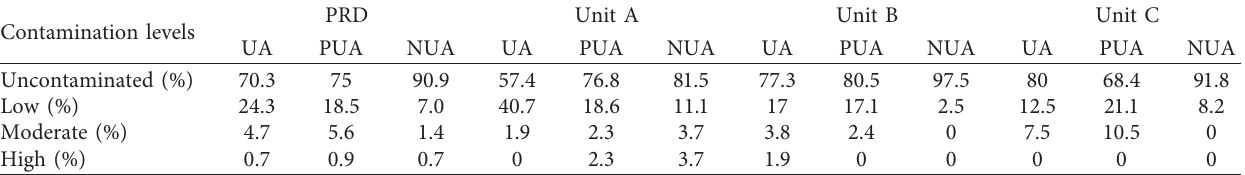
Table 2: Groundwater salinity contamination in areas with different urbanization levels in the Pearl River Delta. Contamination